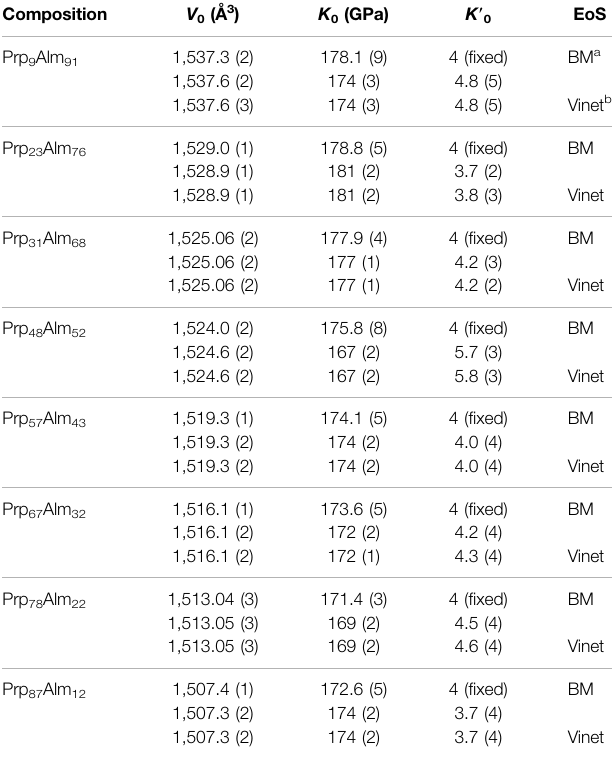
a BM: Birch-Murnaghan EoS. b Vinet: Vinet EoS. Numbers in parentheses represent standard deviations.